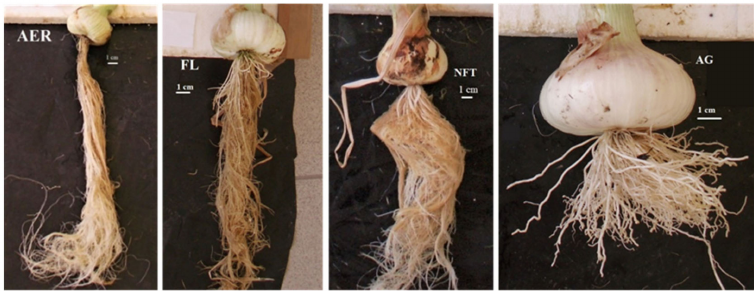
Figure 5. Bulbs and roots of the compared CSCS at 62 DAT (by C.M.).